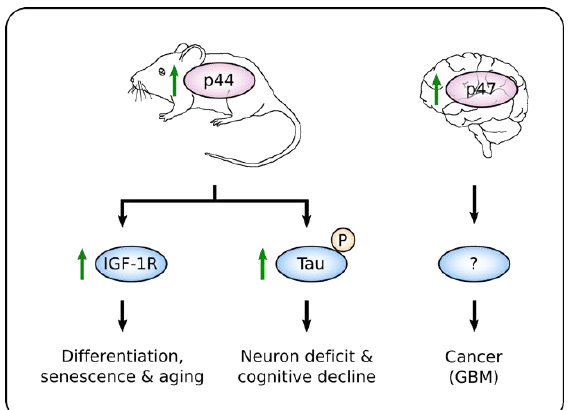
Figure 2. Cellular and physiological responses controlled by higher relative amount of p47/p44. Increased expression of p47/p44 in different tissues and circumstances leads to diverse outputs. High expression of p44 (mouse homolog of p47) promotes differentiation of embryonic stem cells (ESCs) [90] and senescence of several mice tissues leading to a premature aging phenotype through hyper-activation of insulin-like growth factor receptor (IGF-1R) [84]. In normal mice brain tissue, p44-induced expression of Tau kinases results in hyper-phosphorylation of Tau and neuron deficit and cognitive decline [87]. Although elevated expression of p47 was also reported in neural progenitors and in glioblastoma (GBM) samples, the signaling pathway involved is yet unknown [91]. Intriguingly, p44 and p47 were also up-regulated in pluripotent embryonic stem cells (ESCs) from mice and human, respectively, where they maintained a highly proliferative and undifferentiated state through inhibition of the differentiation program driven by p53fl [90]. p47